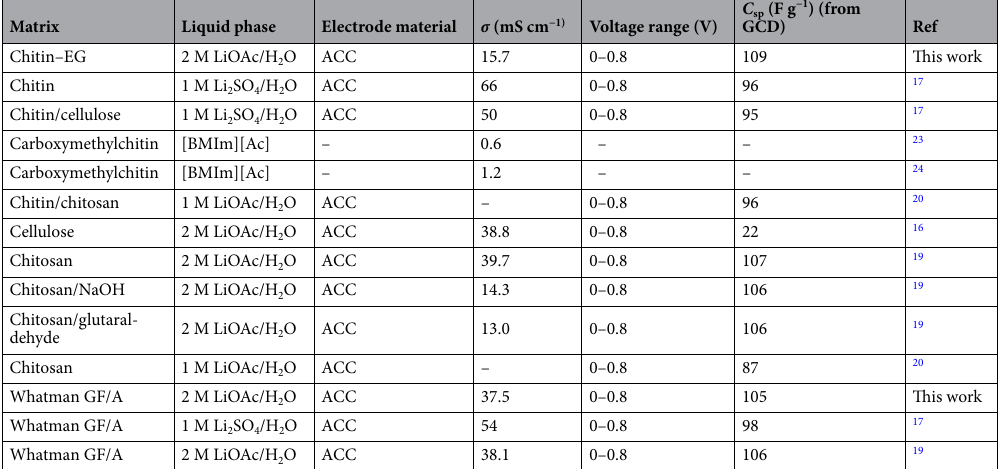
Table 3. Ionic conductivity ( σ ) and specific capacitance ( C sp ) values for EDLC cells with tested membranes, compared with literature data.